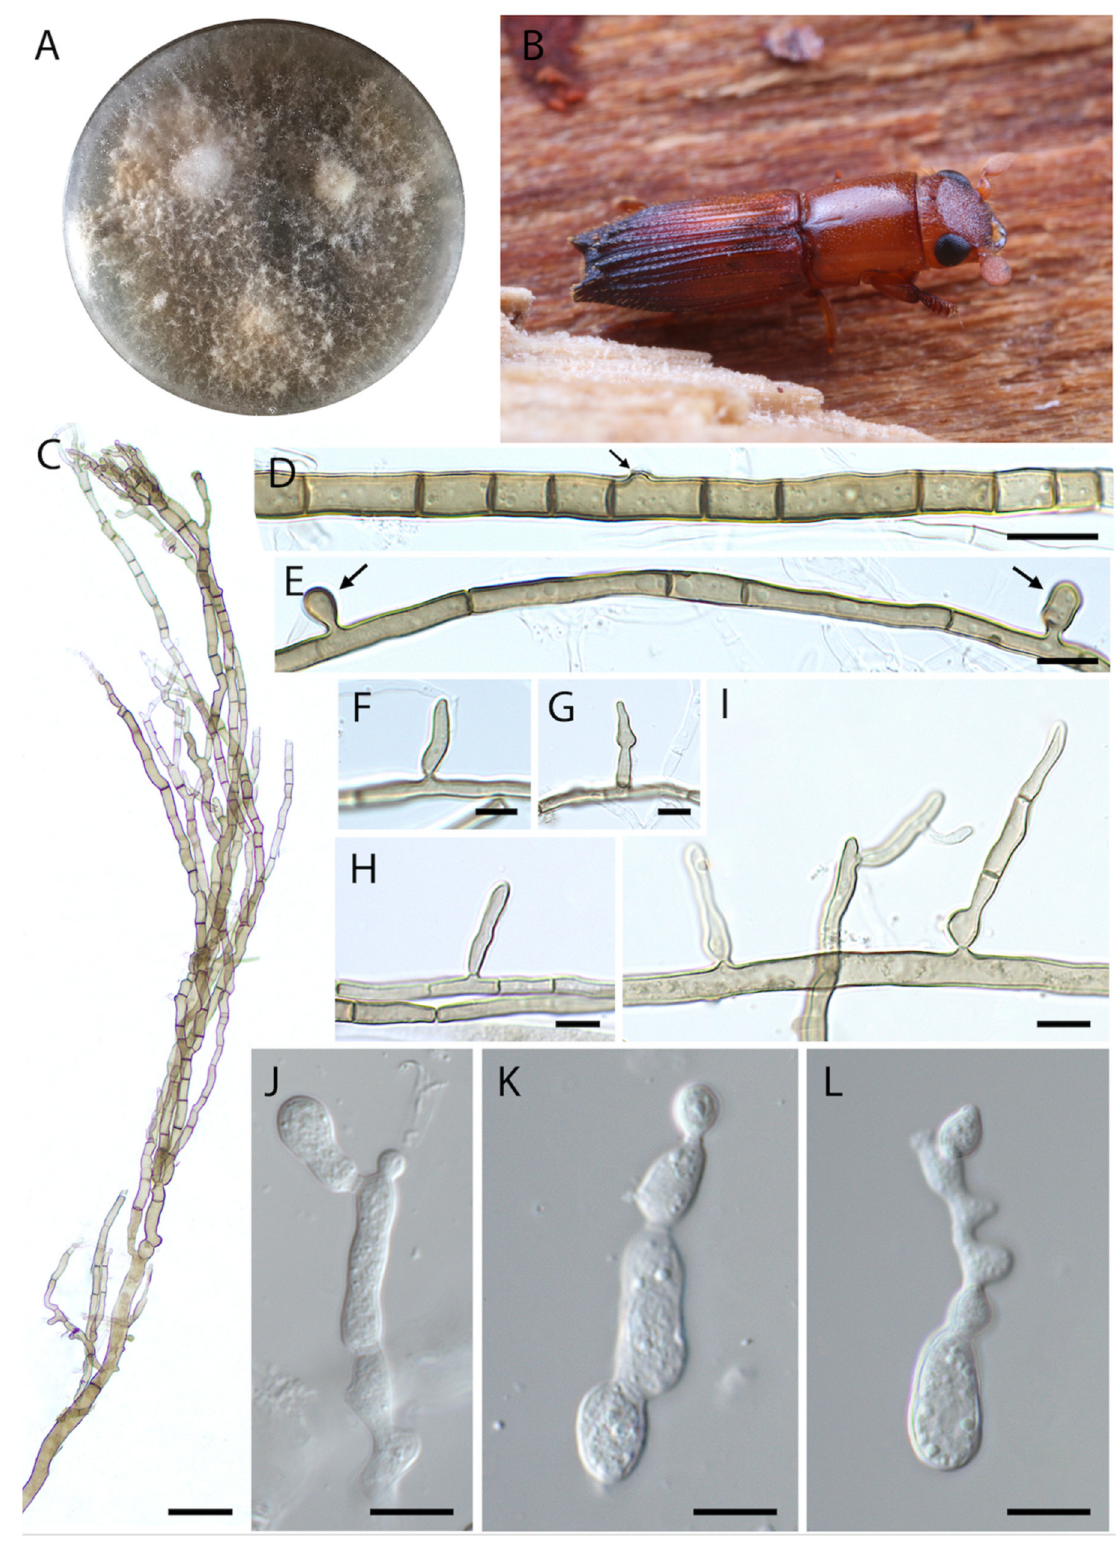
Figure 3. Harringtonia arthroconidialis in pure culture on PDA. ( A ) Colony growth after 3 weeks at 25 ◦ C. ( B ) Beetle vector, Euplatypus parallelus . ( C ) Branched olivaceous hyphae. ( D ) Formation of arthroconidia, arrow indicates site of conidium attachment. ( E ) Micronematous conidiation (early stage). ( F – H ) Sessile conidia. ( I ) Conidia that remained attached forming 1–3 celled propagules. ( J – L ) Yeast-like cells budding. Scale bars: ( C ) = 20 µ m, ( D , E ) = 10 µ m, ( F – I ) = 5 µ m, ( F – I ) = 10 µ